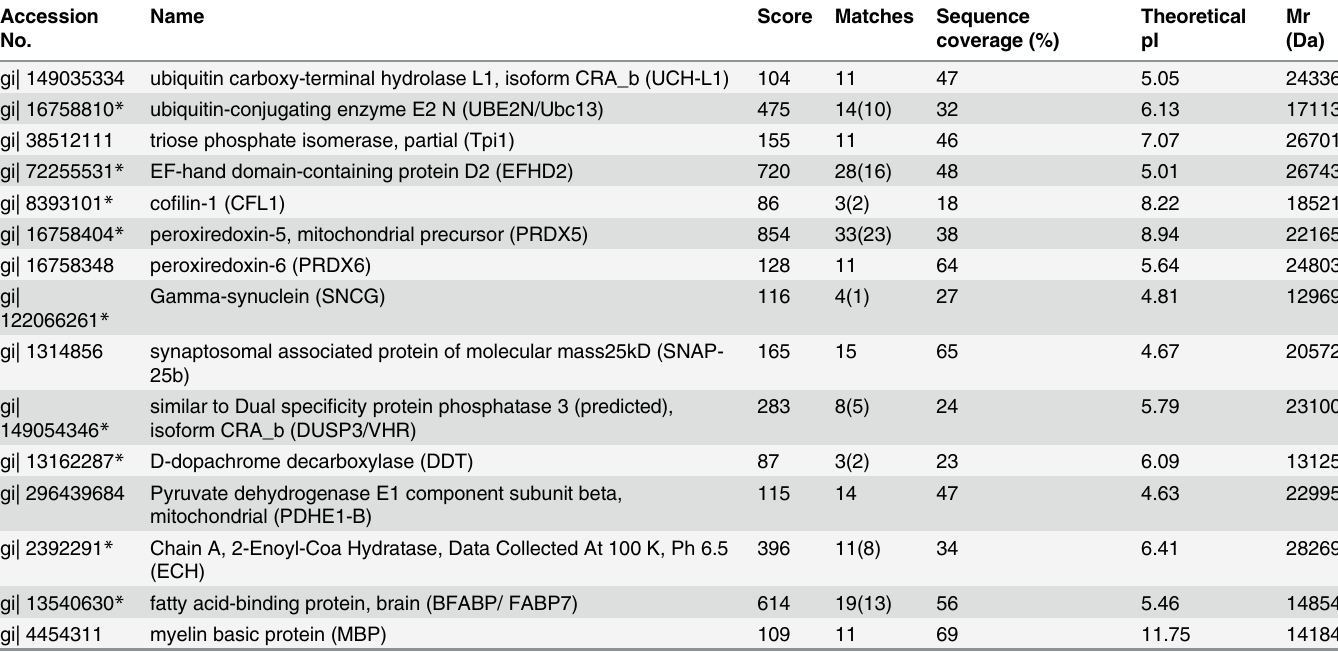
Table 2. NCBI database results from 15 differential proteins identified by mass spectrometry. Accession